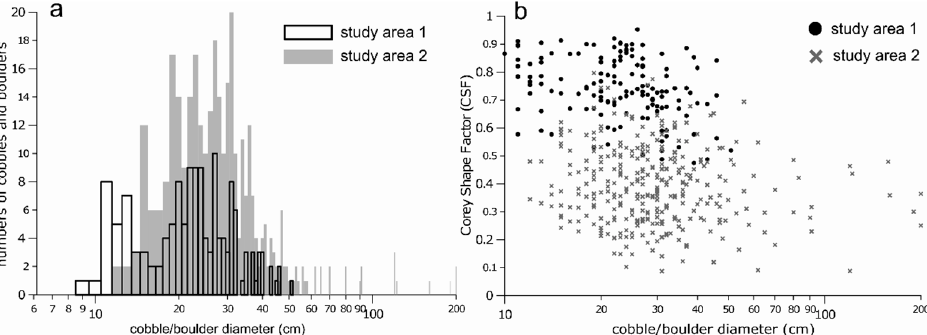
Figure 3. ( a ) Size distribution of all cobbles and boulders analyzed in SA1 and SA2. Sizes are di- vided into centimeter steps; note the logarithmic scale. ( b ) Calculated Corey shape factor (CSF) values vs. cobble/boulder sizes for SA1 and SA2 are